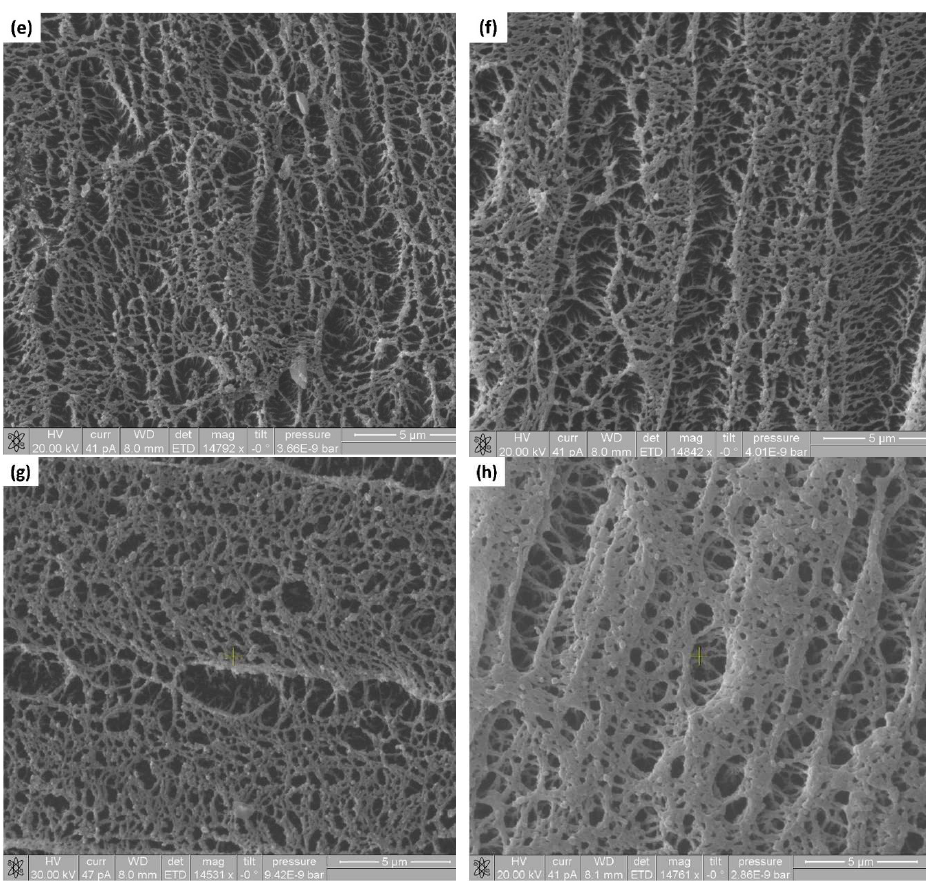
Figure 1. SEM images of, ( a ) PEEK substrate and the deposition of CaP onto PEEK for the samples ( b ) HA10, ( c ) HA30, ( d ) HA60, ( e ) HA150, ( f ) HA300, ( g ) HA450, and ( h ) HA600.